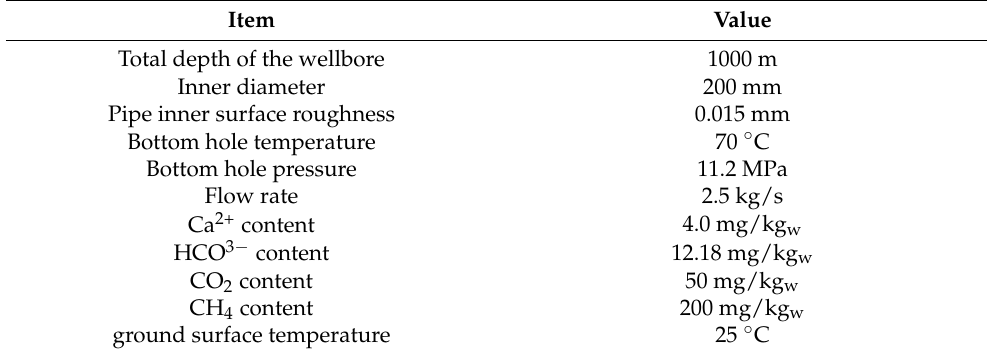
Table 3. Example input parameters.